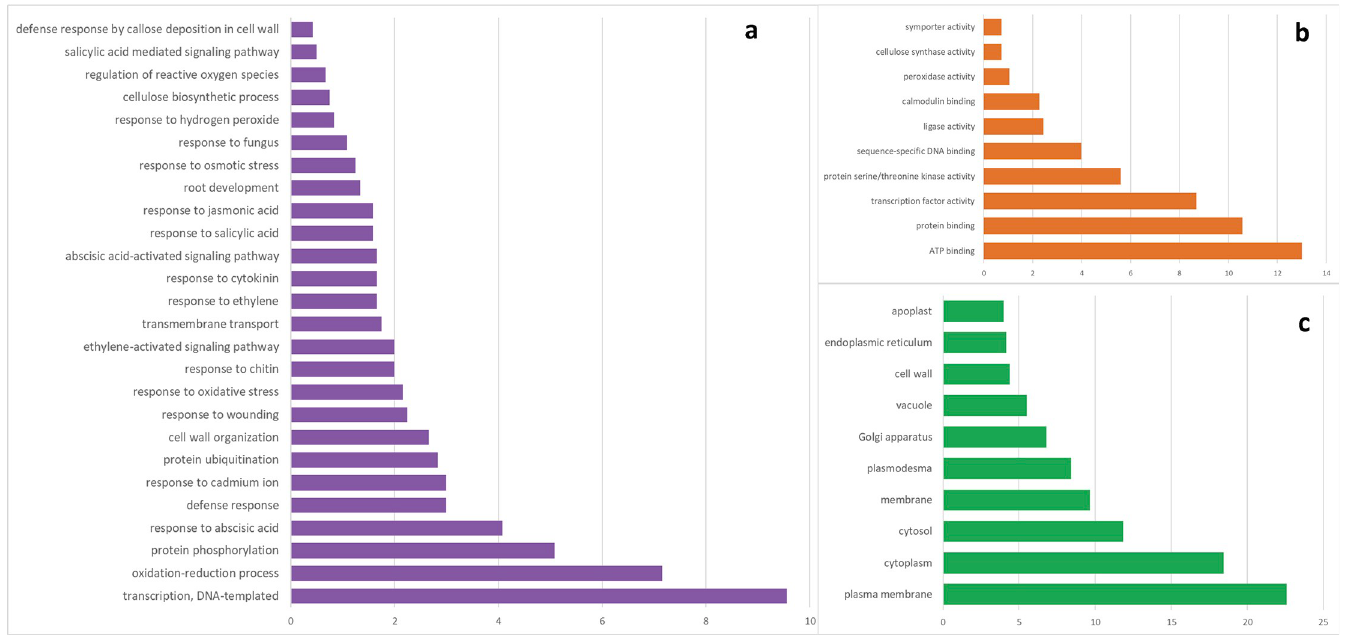
Fig 3. GO enrichment terms. (a) biological process, (b) molecular function, (c) Cellular